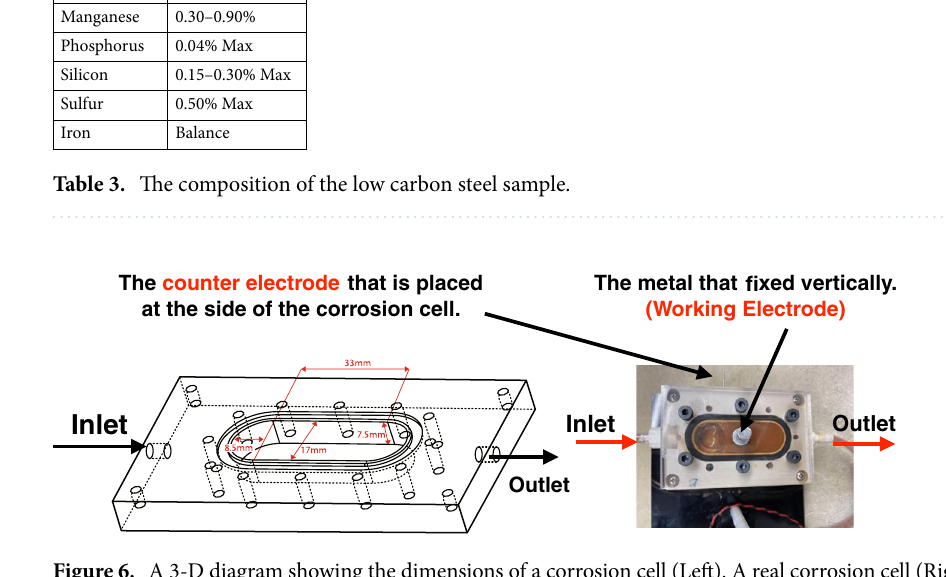
Figure 6. A 3-D diagram showing the dimensions of a corrosion cell (Left). A real corrosion cell